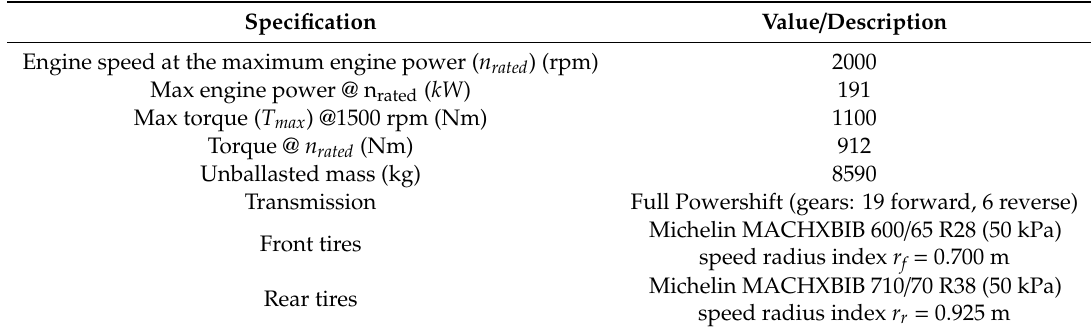
Table 1. Specification of the New Holland T7.260 (TT) used for the field tests. Specification